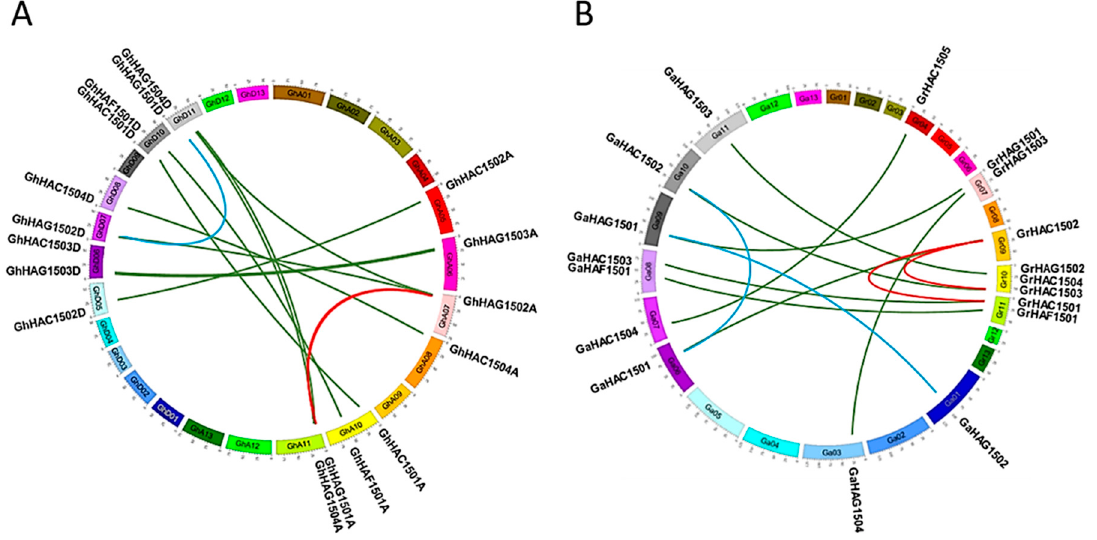
Figure 3. Chromosomal distribution and gene duplication of HATs in Gossypium hirsutum ( A ) and in Gossypium raimondii and Gossypium arboretum ( B ). The chromosome number was indicated in boxes and represented as Gh1-Gh13A / D ( A ), Ga1-Ga13, and Gr1-Gr13 ( B ) for G. hirsutum , G. raimondii , and G. arboretum , respectively. The orthologous HATs are connected by green, while the segment duplication of HATs is represented by light blue and red colors in di ff erent